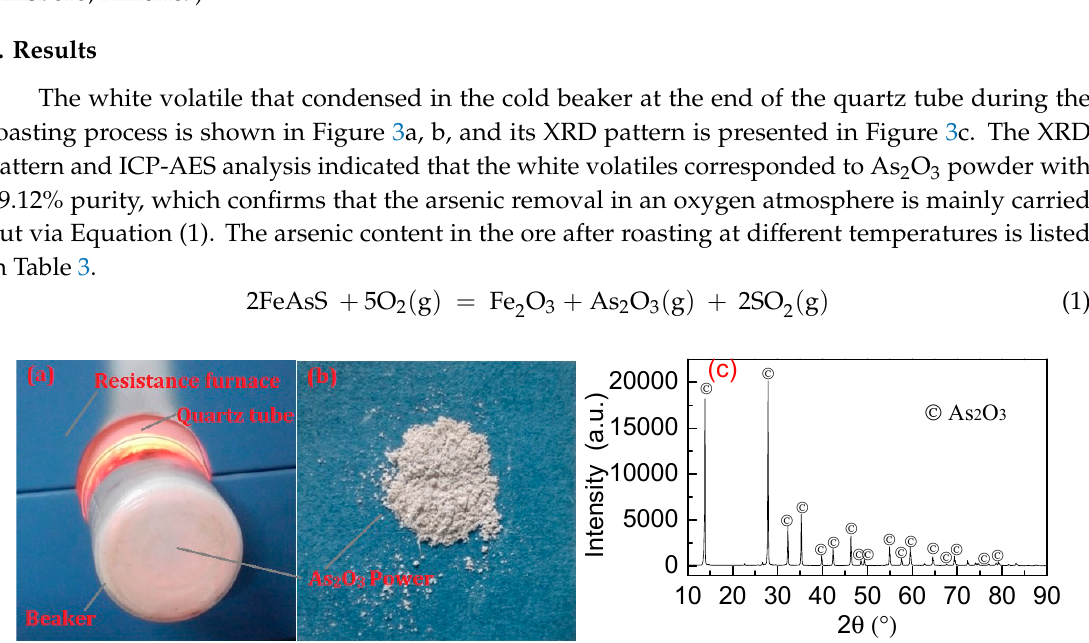
Figure 3. ( a ) Arsenic removal from mixed ore by roasting in resistance furnace with quartz tube under air atmosphere and 1000 ° C; ( b ) Collected As 2 O 3 powers condensed in cold beaker; (c) XRD spectra of collected As 2 O 3 powers condensed in cold beaker. Table 3. Arsenic removal rate of ore subjected to roasting.